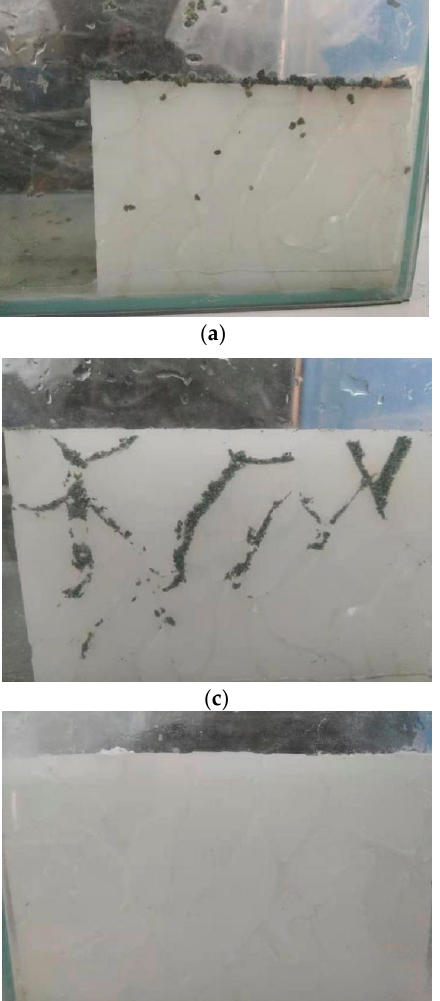
Figure 7. ( a ) 1.18 mm particle size or more ( b ) 0.6 mm–1.18 mm particle size. ( c ) 0.3 mm–0.6 mm particle size ( d ) 0.15 mm~0.3 mm particle size. ( e ) 0.075 mm~0.15 mm particle size ( f ) 0.075 mm or less particle size.